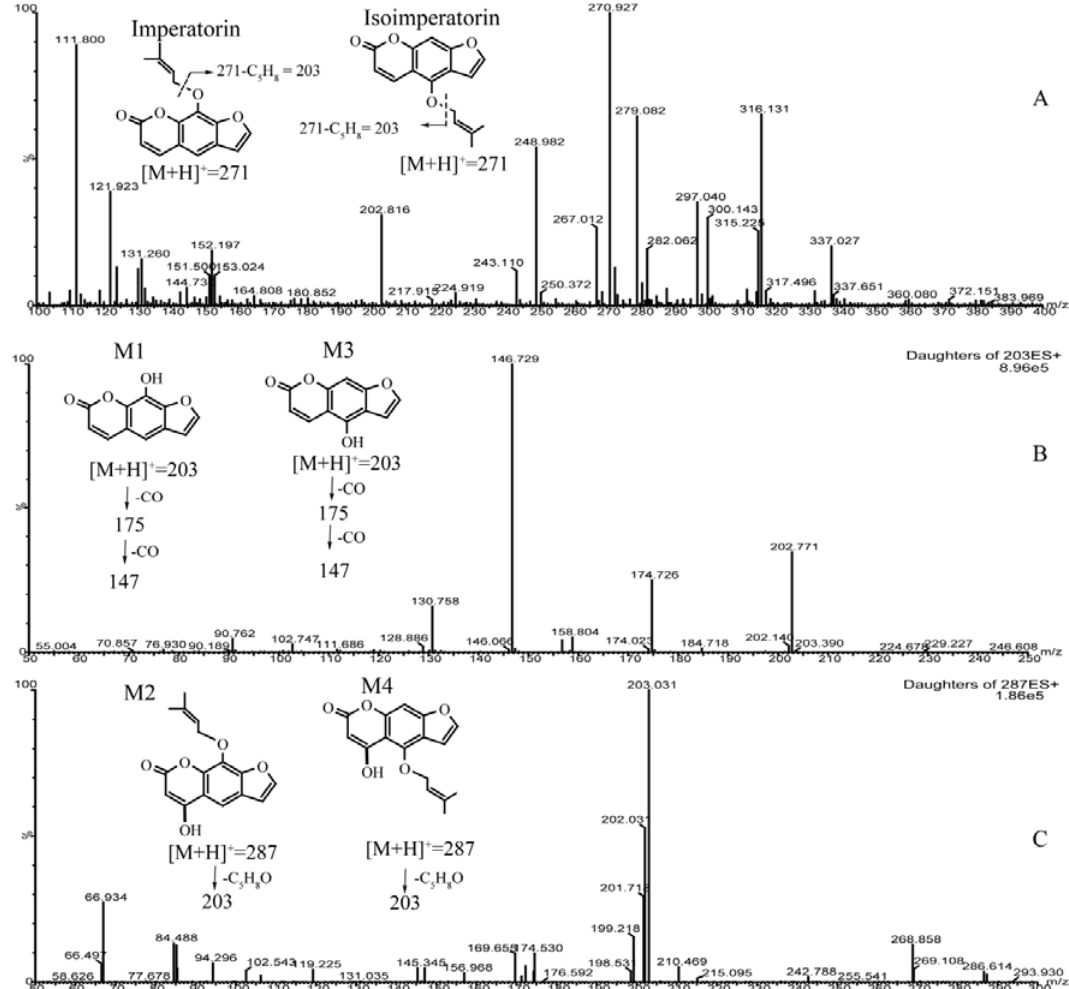
Figure 4. Populated imperatorin and isoimperatorin metabolites in human liver microsomes. ( A ) Imperatorin or isoimperatorin gave the protonated molecule [M + H] + at m / z 271, and the MS 2 spectrum showed prominent ions at m / z 203 ([M + H − C 5 H 8 ] + ). ( B ) M1 and M3 gave [M + H] + at m / z 203, with MS 2 spectrum showed prominent ions at m / z 175 ([M + H − CO] + ) and m / z 147([M + H − 2CO] + ). ( C ) M2 and M4 gave [M + H] + ion at m / z 287, with MS 2 spectrum showed prominent ions at m / z 203([M + H − C 5 H 8 O] + ).